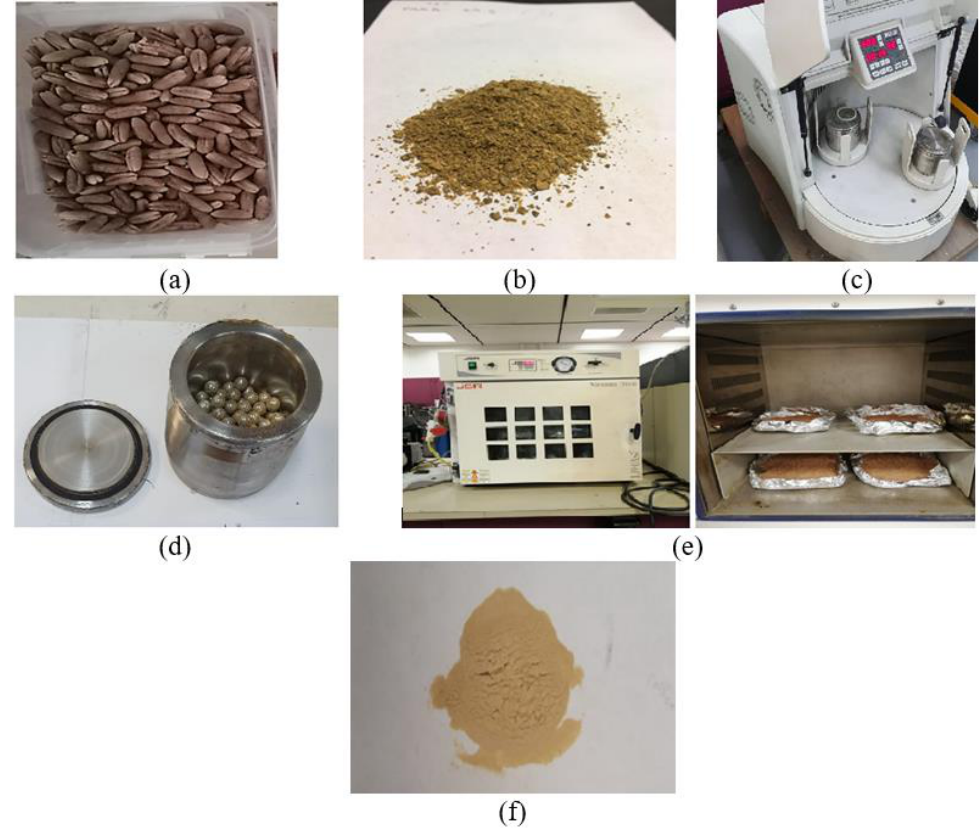
Figure 1. Preparation of date pit particles: ( a ) raw date pits after initial drying, ( b ) date pit particles after initial grinding process, ( c ) ball milling machine, ( d ) balls and date pit powder inside the ball milling jar, ( e ) final drying process, and ( f ) date pit power as a filler.